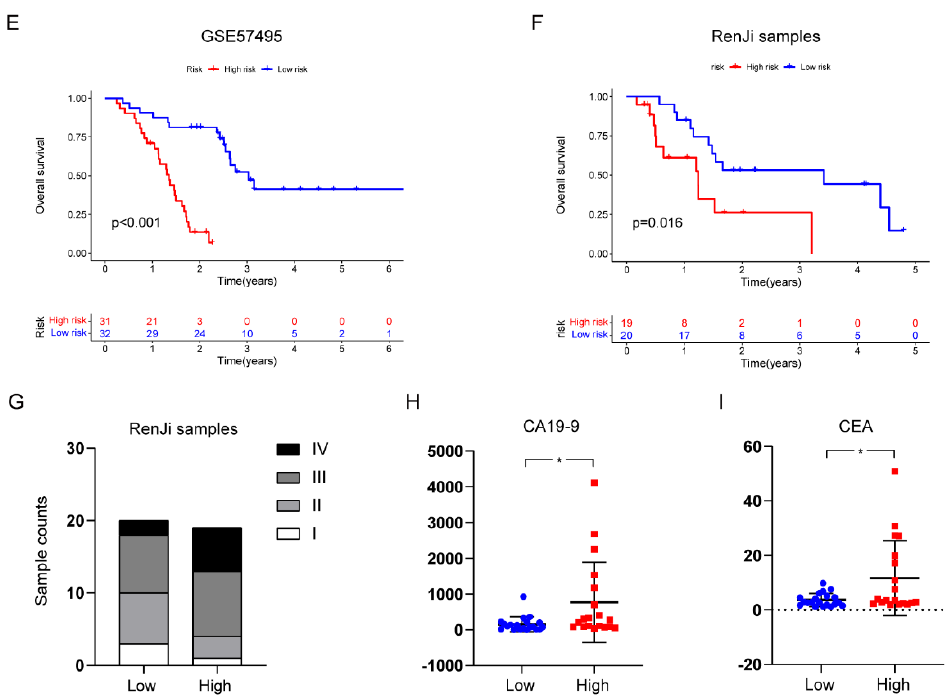
Figure 10. Verification of the Stroma- and Metastasis-Associated Risk Prognostic Model in Public Database and RenJi Samples. ( A – D ) The expression profile of the risk gene signature in TCGA and GTEx datasets ( tumor tissue was indicated in red and normal tissue in gray); ( E , F ) Survival curves regarding high- and low-risk groups in GSE57495 database and RenJi sample; ( G ) Different TNM stage counts in the high- and low-risk groups in RenJi sample; ( H , I ) Differences in tumor markers (CA19-9 and CEA) between high- and low-risk groups. * p < 0.05.